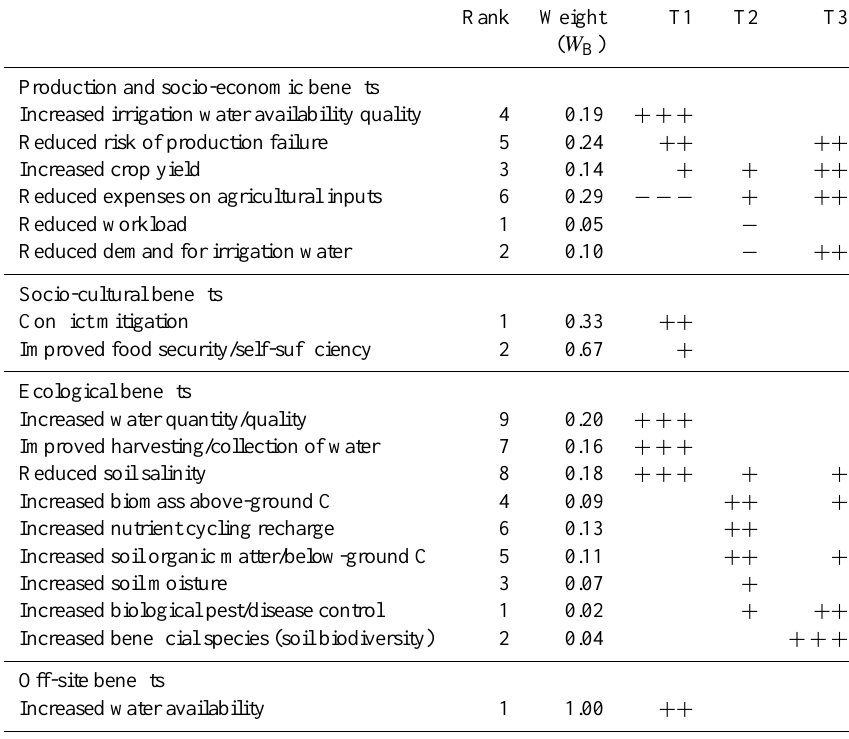
Table 4. Comparison of the ecosystem and human well-being impacts of each technology along with average ranking of each benefit according to